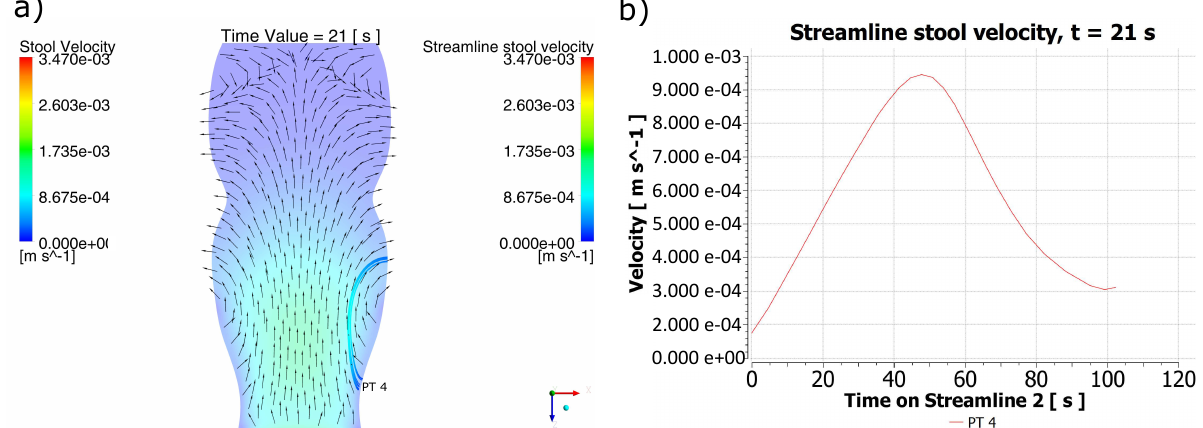
Figure 4. Behavior of the stool for t = 21 s. ( a ) Stool flow lines from the region of the polyp PT 4 for t = 21 s. ( b ) Velocity for the stool flow lines. It can be identified that in the PT4 particle release area, the direction of the fecal mass formed a retrograde trajectory. However, due to changes in the position of the peristaltic contraction, there was a variation in the magnitude of the maximum velocity reached during a new predicted trajectory, indicating a region much further from the point of origin of the biomarker